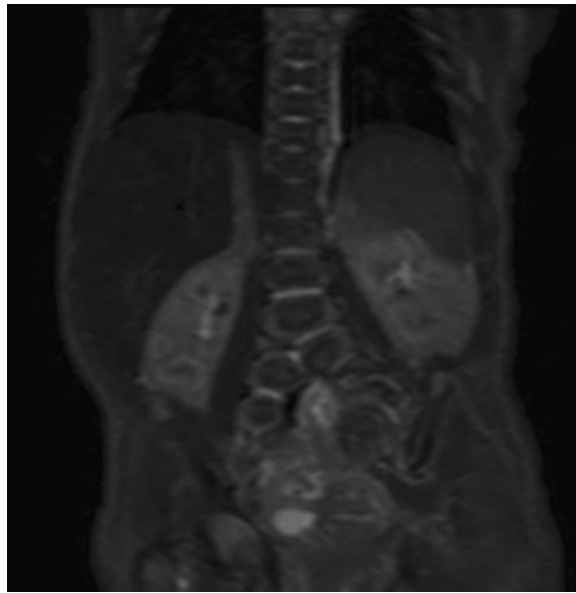
Fig. 5 Coronal MRI of the abdomen showing split of the spinal vertebrae below the dorsolumbar